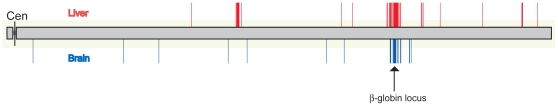
Distribution of 4Cv results on chromosome 7. Sequencing analysis of 4Cv experiments reveals the distribution of intrachromosomal interactions of Hbb-b1 in E18.5 liver (red lines, top) and brain (blue lines, bottom) cells.The centromere and β-globin locus are marked by a black line and arrow respectively.